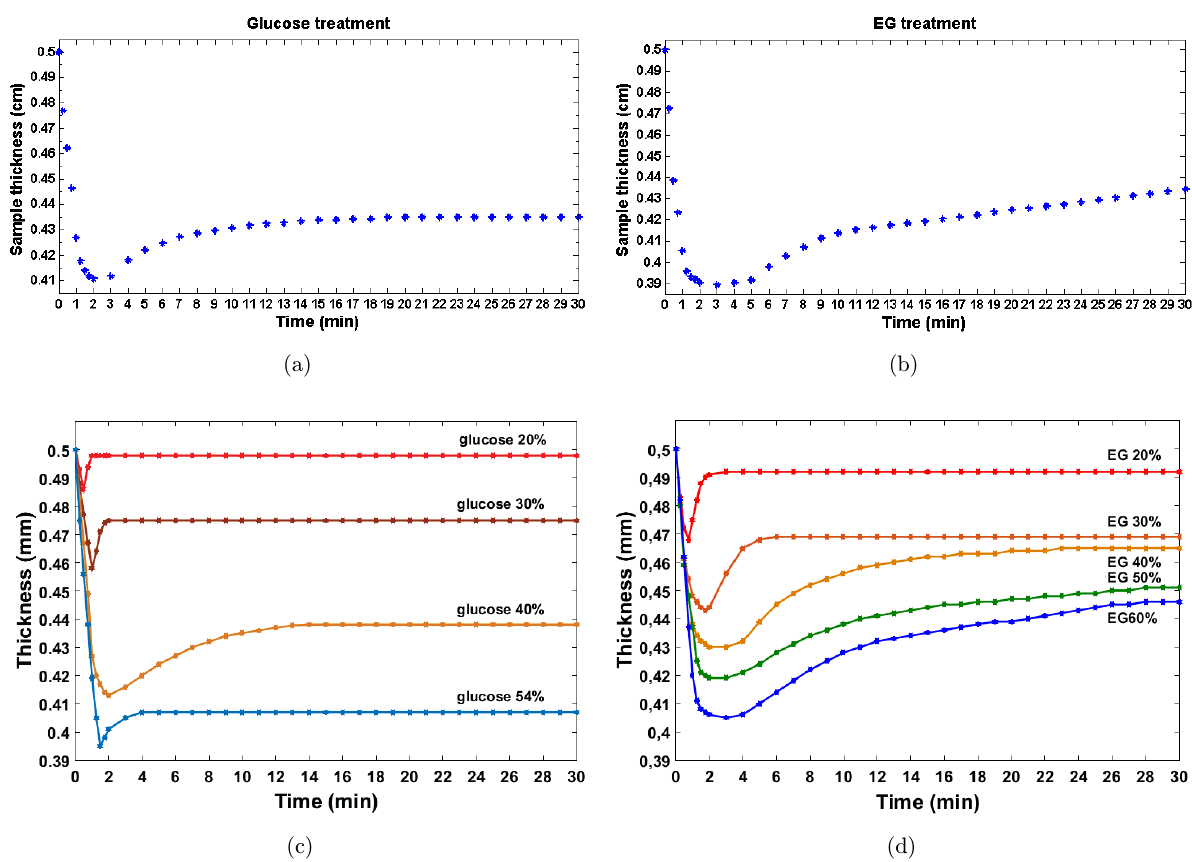
Fig. 4. Thickness time dependence for: (a) rat muscle treated with 40% glucose (mean of three studies); (b) rat muscle treated with 99% EG (mean of three studies); (c) bovine muscle treated with di®erent concentrations of glucose; (d) bovine muscle treated with di®erent concentrations of